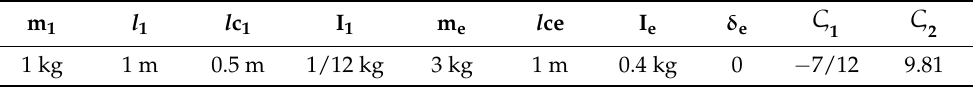
Table 2. Physical parameters of two joint manipulator.